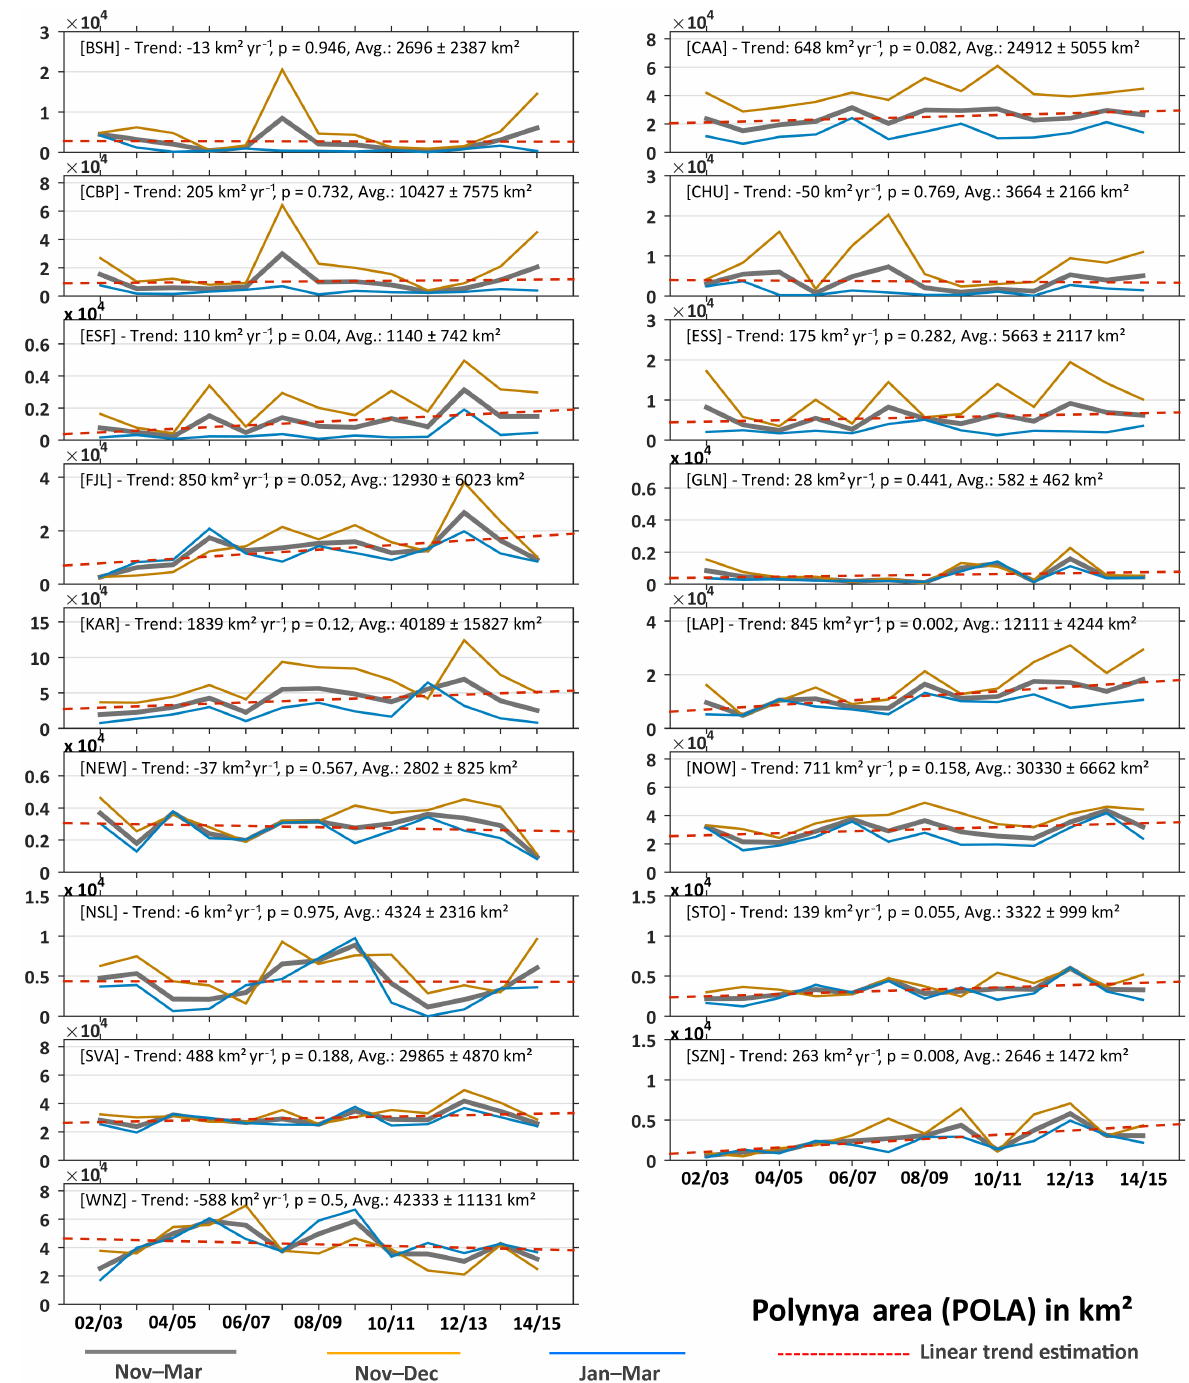
Figure 5. Regional time series of the annual average polynya area (POLA; TIT ≤ 0.2m) in km 2 from 2002/2003 to 2014/2015, together with a seasonal comparison (November to December vs. January to March) and a linear trend estimation. The estimated linear trend (in km 2 yr − 1 ), its p value and the interannual average POLA (in km 2 ) are additionally listed in each subpanel. Please note the varying scale on each y